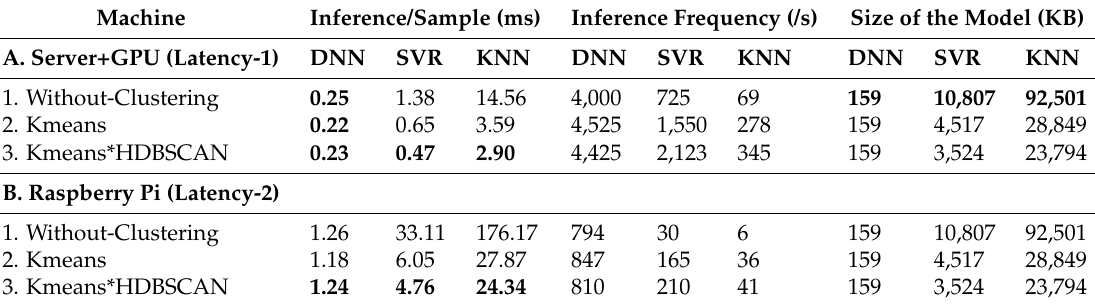
Table 13. Testing Time, Frequency, and Model Size Comparisons of the DNN, SVR, and